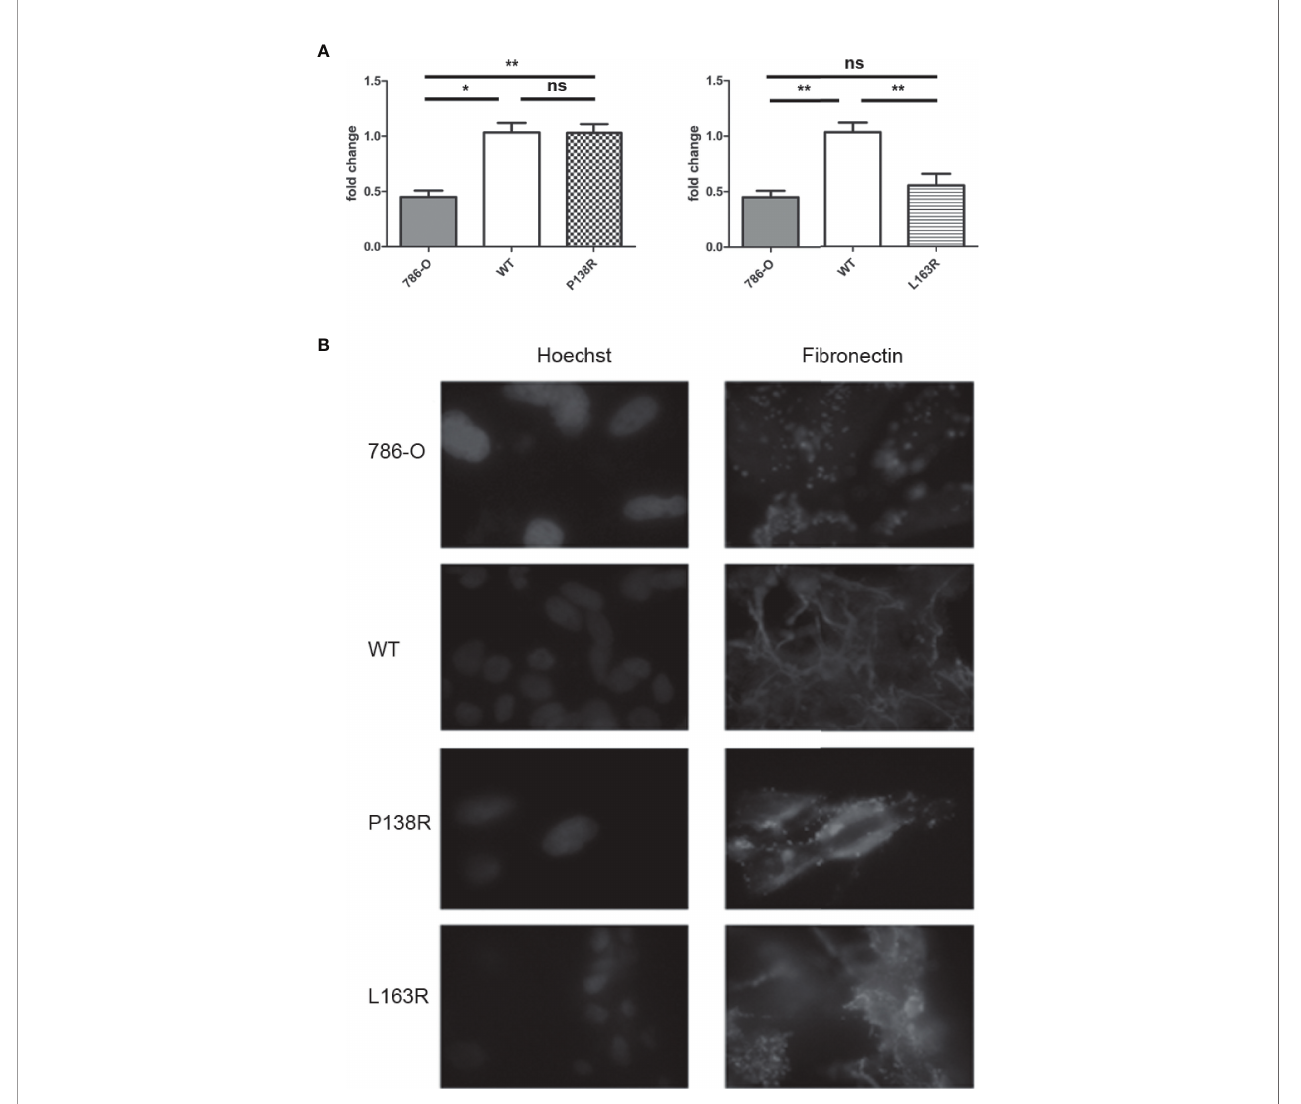
FIGURE 3 | Differences in mRNA fi bronectin expression for P138R and L163R pVHL variants with similar disrupted deposition patterns. (A) Fibronectin mRNA expression of 786-O, WT, P138R, and L163R cell lines. Results are presented as fold change compared to WT cells. Values are expressed as ± SD of three independent experiments performed in triplicate. ns, not signi fi cant; *p = 0.0011, **p = 0.0030, one-way ANOVA and Tukey ’ s posttest. (B) Cell lines were cultured on coverslips to assess fi bronectin deposition with anti- fi bronectin Cy5 conjugated (in red) by immuno fl uorescence. Nuclei were dyed with 5 m g/ml Hoechst as shown in blue. Images were taken at ×40 on a Carl-Zeiss AxioScope A1